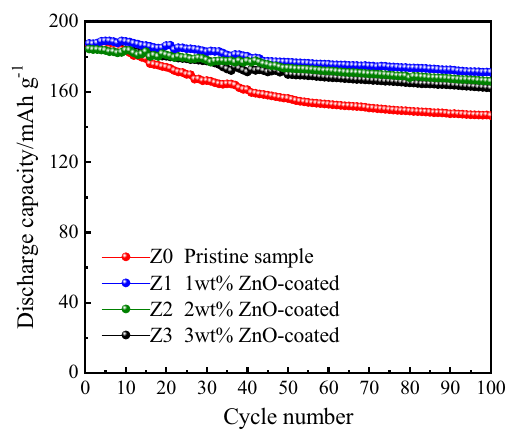
Figure 6: Cycling performance of the pristine and ZnO - coated LiNi 0.8 Co 0.15 Al 0.05 O 2 samples at